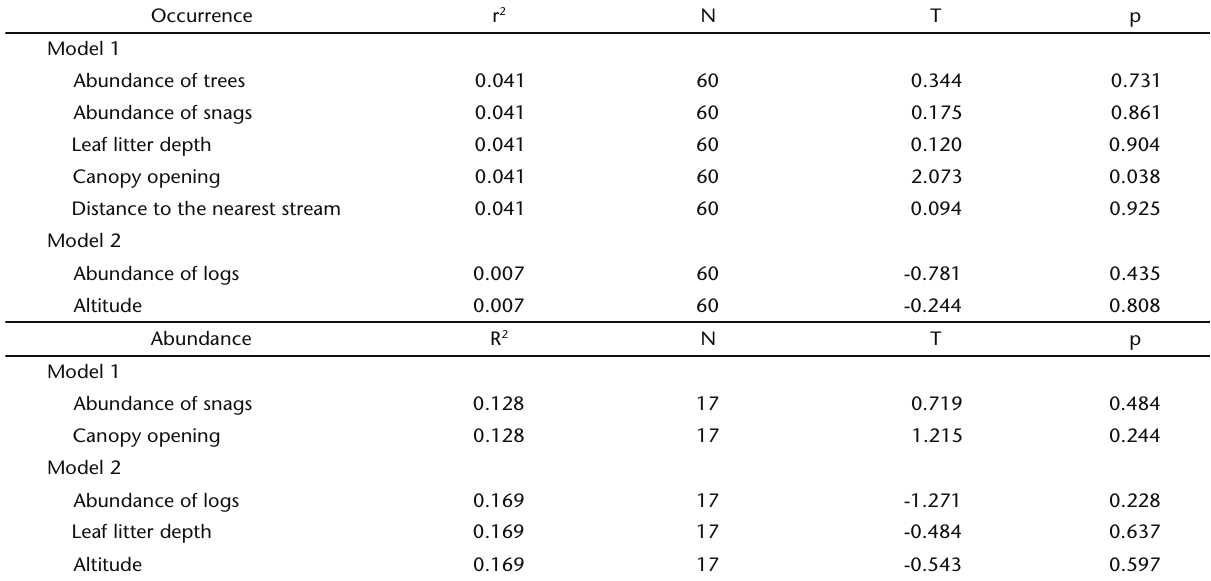
Table VI. Results of the multiple logistic regression for frequency of use (occurrence) of different sites in the forest by G. hardyi (categorical variable 0 = owl absent, 1 = owl present) and results of the multiple linear regression for owl's abundance in relation to the forest structure components and features of landscape.